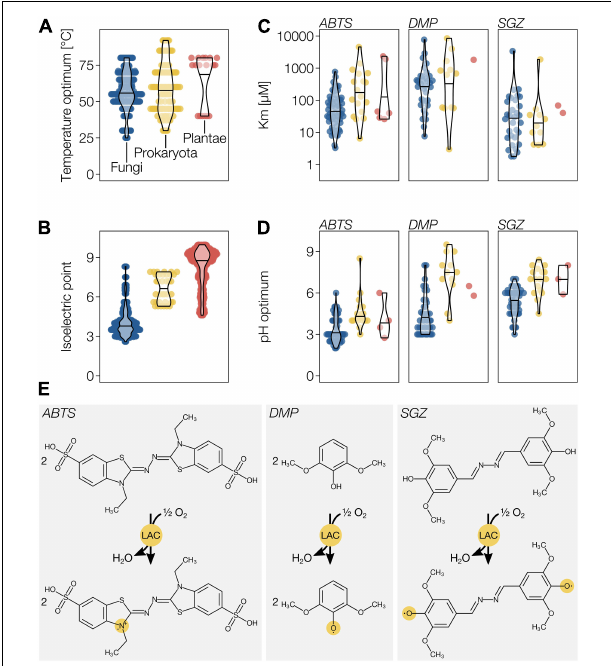
FIGURE 6 | Bibliometric analysis of LAC enzymatic parameters. (A) Temperature optimum of LACs activity from fungi, prokaryota and plants. (B) Isoelectric points of LACs from the three kingdoms. Note that most of the isoelectric point data represent calculated values rather than experimental ones. (C) Km values of LACs from the three kingdoms for the classical non-phenolic substrate 2,2 (cid:48) -azino-bis(3-ethylbenzothiazoline-6-sulphonic acid) (ABTS) and two common phenolic substrates (DMP, 2,6-dimethoxyphenol; SGZ, syringaldazine). (D) Optimal pH for the oxidation of ABTS, DMP and SGZ. (E) Schematic representation of LAC mediated oxidation of ABTS, DMP and